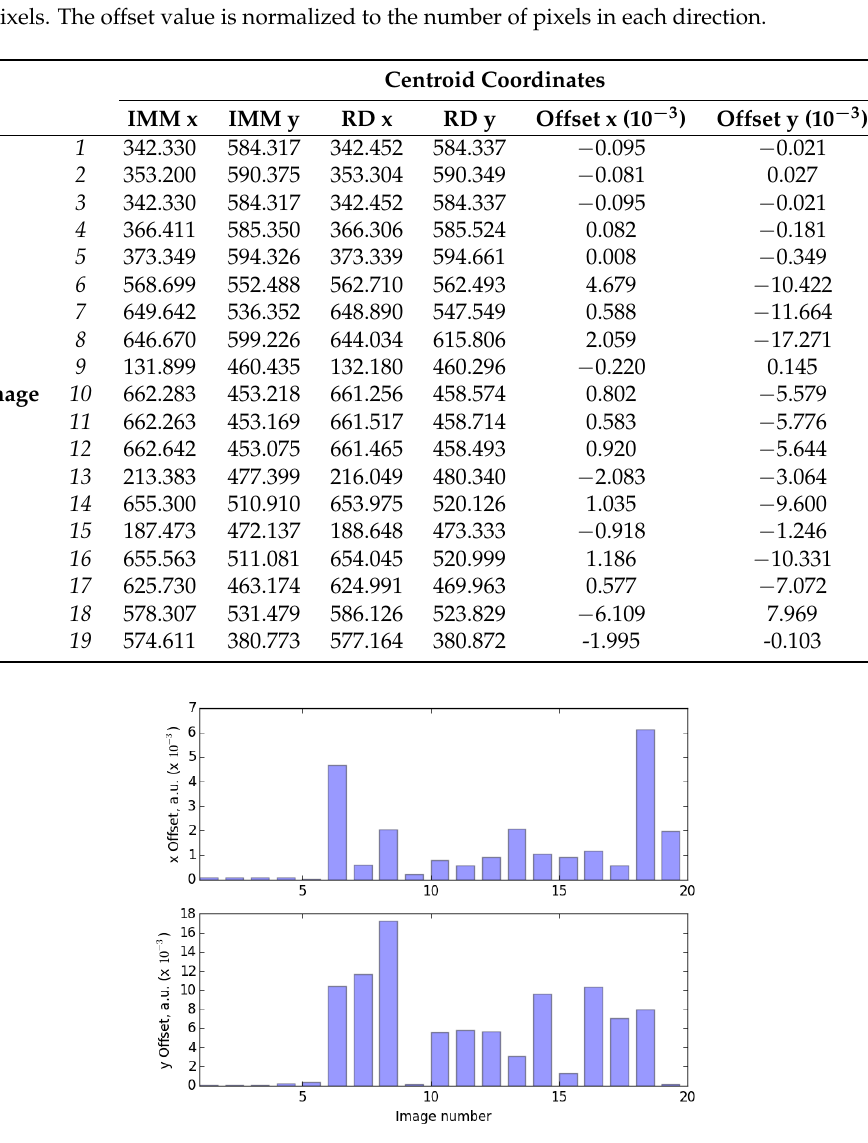
Figure 6. Illustration of the results depicted in Table 2. The height of each bar corresponds to the distance between centroids calculated by both